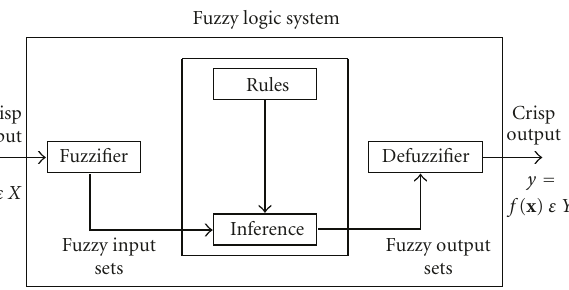
Table 1: The rules for target detection. Antecedent 1 is centroid of a RoI , Antecedent 2 is the number of fluctuating points in the ROI , and Consequent is the possibility that there is a target at this RoI